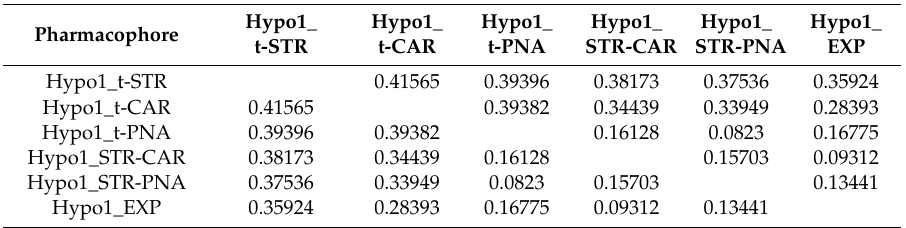
Table A1. Proximity matrix between the most reliable hypotheses obtained by the cluster analysis protocol of the pharmacophores.